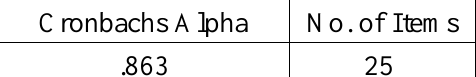
Table 4: Reliability Analysis